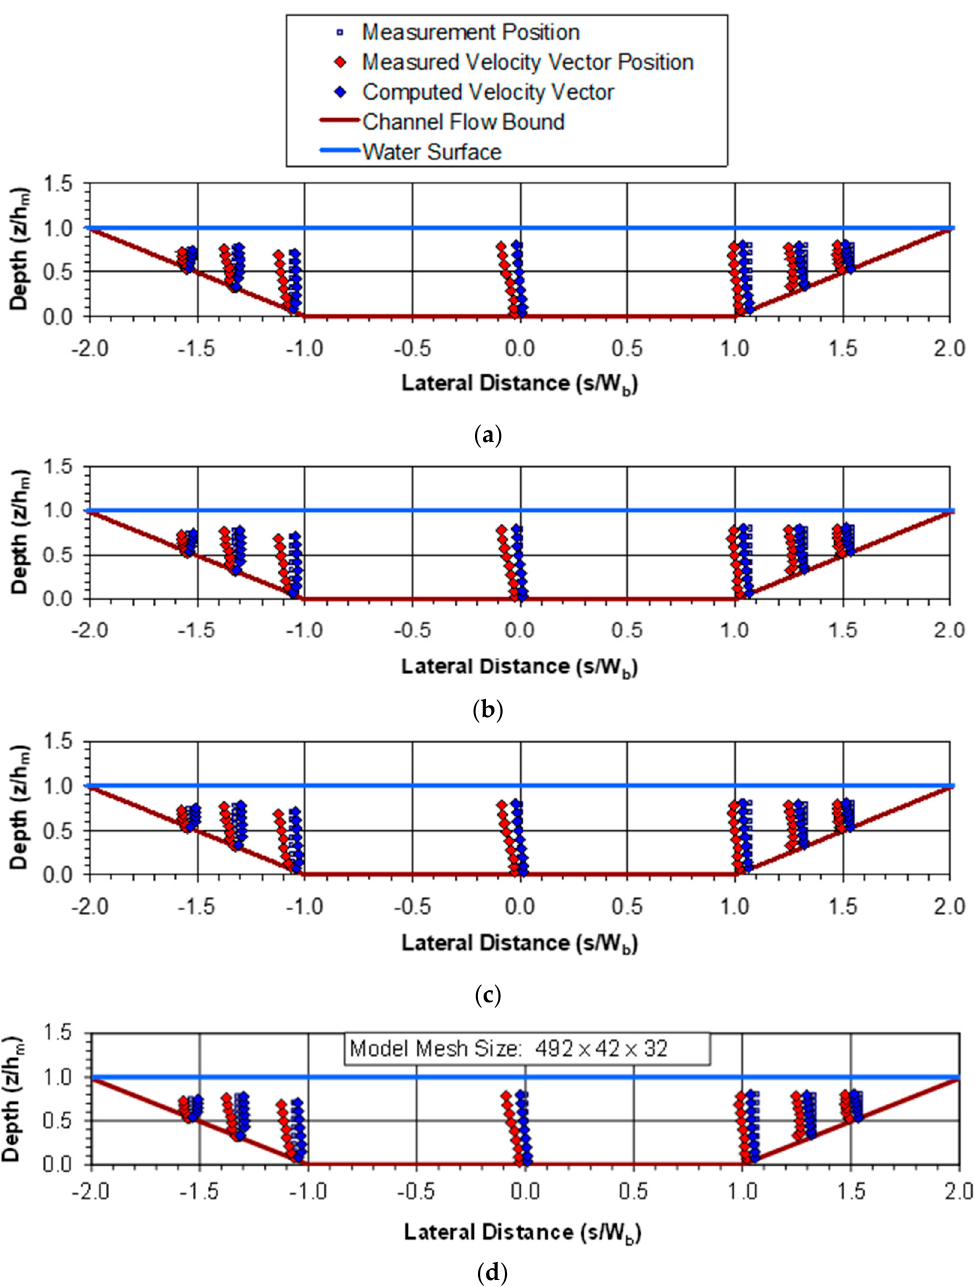
Figure A18. Comparison of simulated and measured cross-stream velocities at Cross-section 10 using four di ff erent 3D mesh sizes. ( a ) 327 × 21 × 16; ( b ) 492 × 21 × 16; ( c ) 492 × 32 × 24; ( d ) 492 × 42 ×